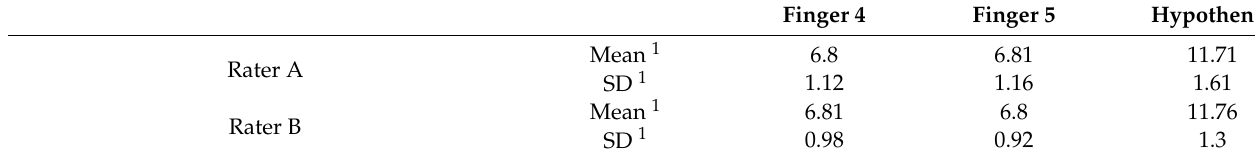
Table 4. Reliability and validity of two-point discrimination (2PD)—CuTS patients (n = 21).